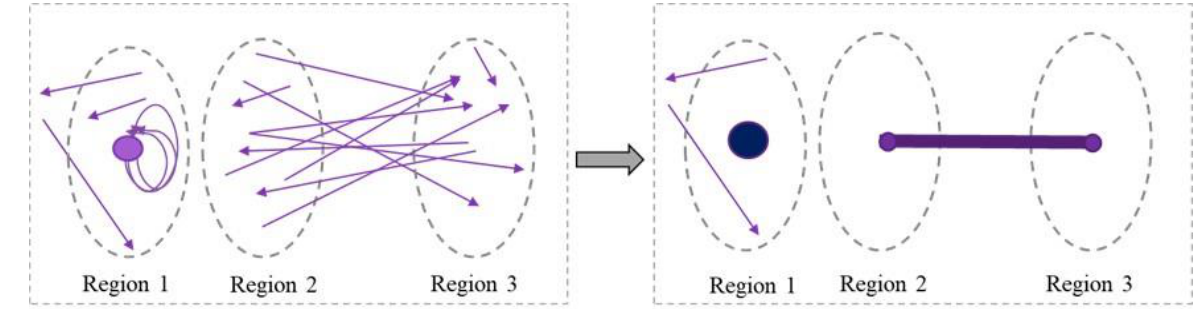
Figure 3. Spatial aggregation of “Dwelling–Travelling for Charging” (DTFC) flow based on the town-neighborhood unit (Jiedao).